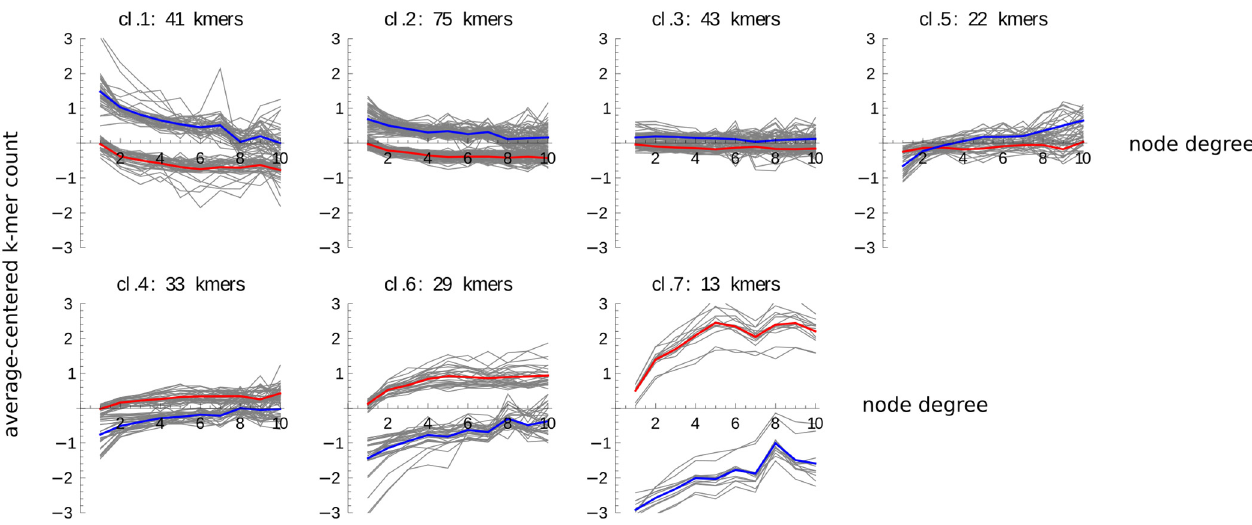
Figure 2. Clustered average k-mer count profiles of promoters and enhancers as the function of the node degree. The profiles of average counts of every k-mer as the function of the node degree were computed for degrees 1–10. This was done separately for promoters and for enhancers, and the two resulting profiles (vectors of length 10 indexed by the node degree) for the same k-mer in the promoters and in the enhancers were joined (head to tail) in that order, resulting in vectors of length 20. These vectors were then centered by subtraction of the joint profile average value and clustered using the k-medoid algorithm (Mathematica v. 8, Wolfram Research), with the number of statistically significant clusters determined automatically using the gap statistics. The results of the clustering were cut between the promoter and the enhancer part and the two halves are plotted alongside each other as the function of the node degree. The promoter part is marked by plotting its median profile in red and the enhancer part by plotting its median profile in blue.